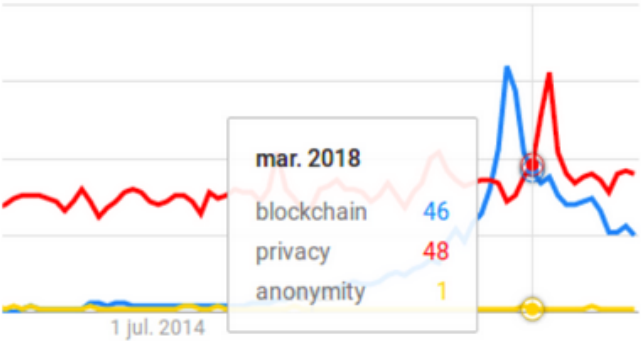
Figure 2. Increased popularity of the term privacy versus blockchain.